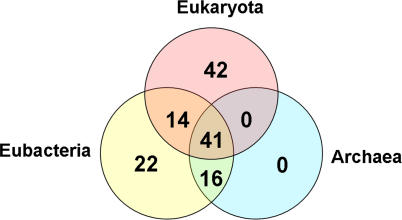
Venn Diagram Showing the Distribution of Transporter Families across the Three Domains of Life